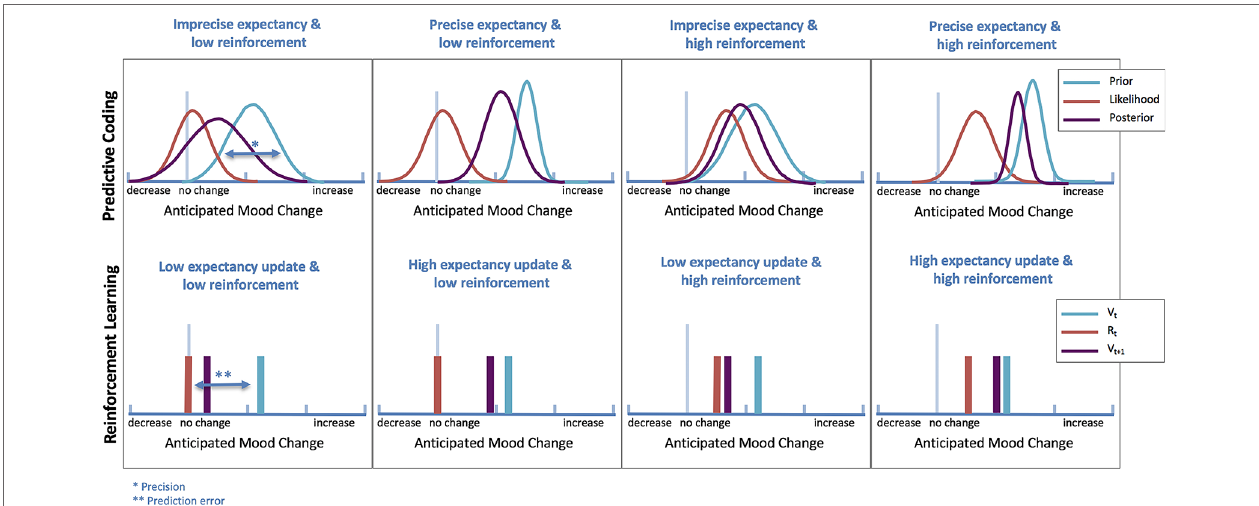
FIGURE 3 | Computational theories of antidepressant placebo effects. Illustration of differences in antidepressant placebo effects under predictive coding (top) and RL (bottom) theories (simulated data). In predictive coding theories, expectancy updating based on the strength of expectancy of improvement is operationalized as differences in precision (narrowness of prior), while in RL, is operationalized by incorporating a prediction error (PE), which signals the mismatch between what it is expected (Vt) and what it is perceived